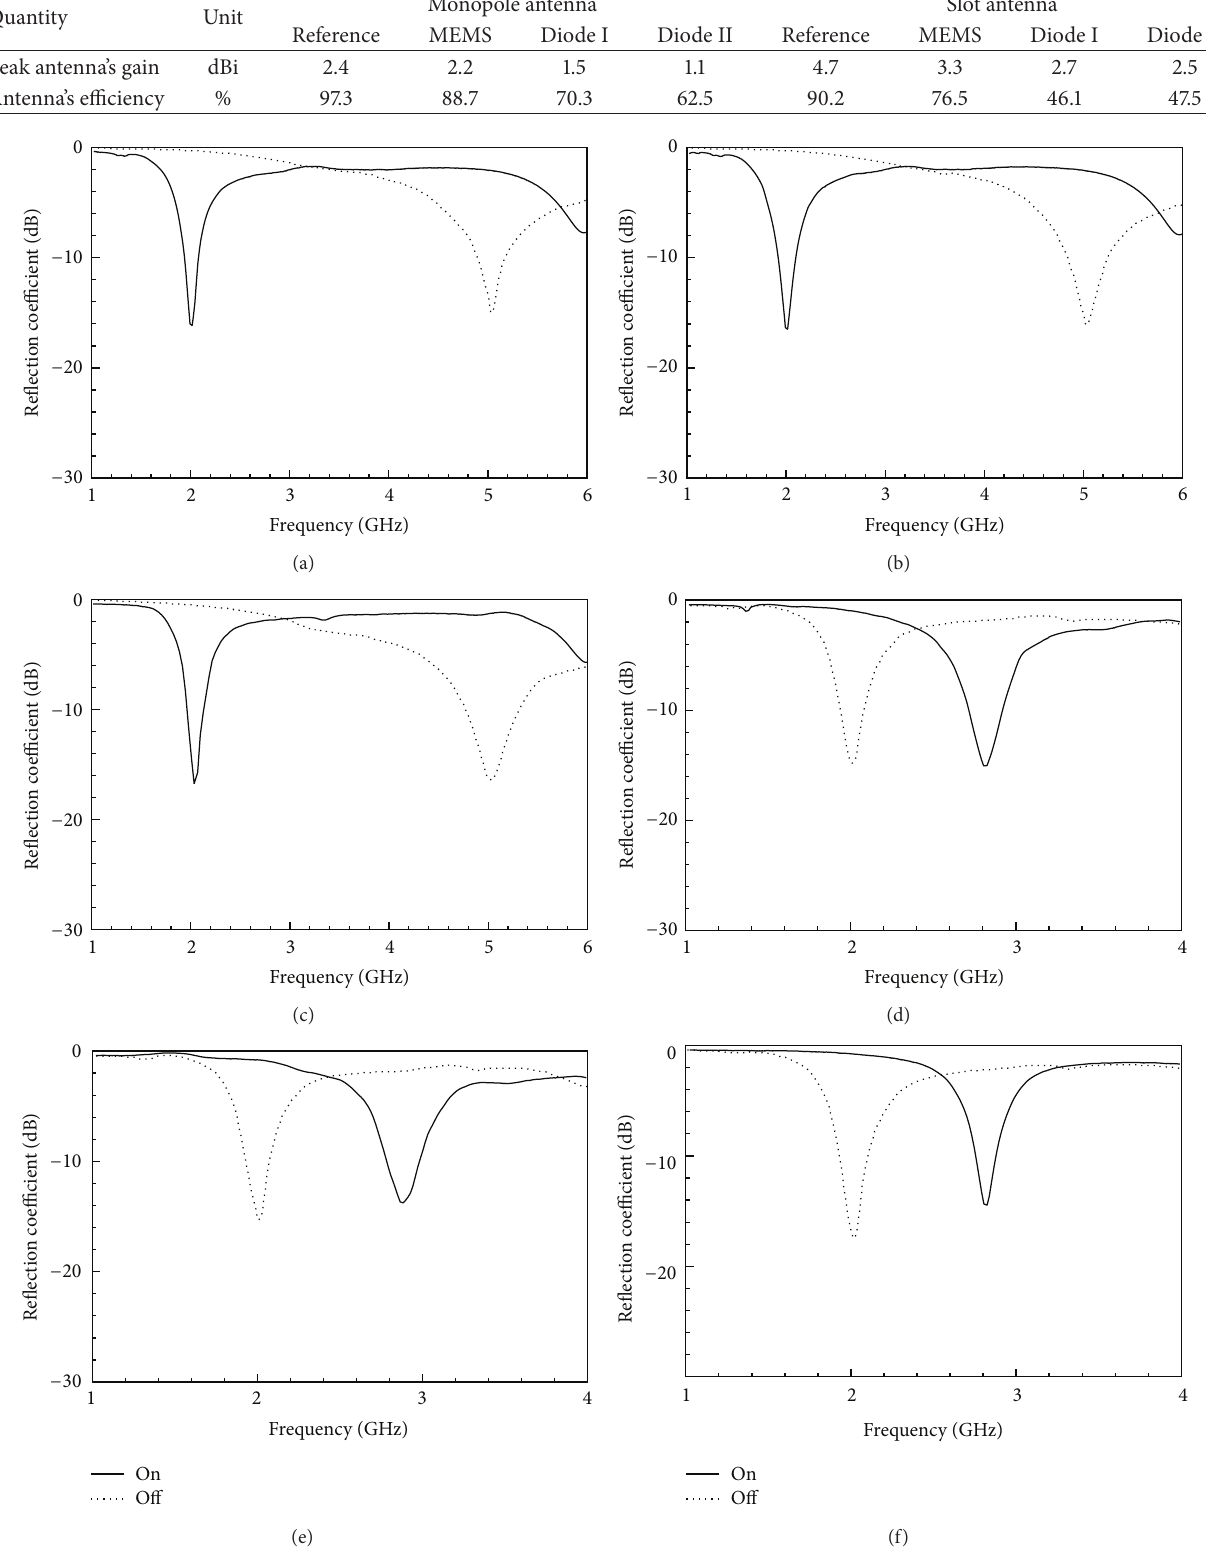
Table 1: Comparison of the measured efficiency and peak gain of the reconfigurable antennas.